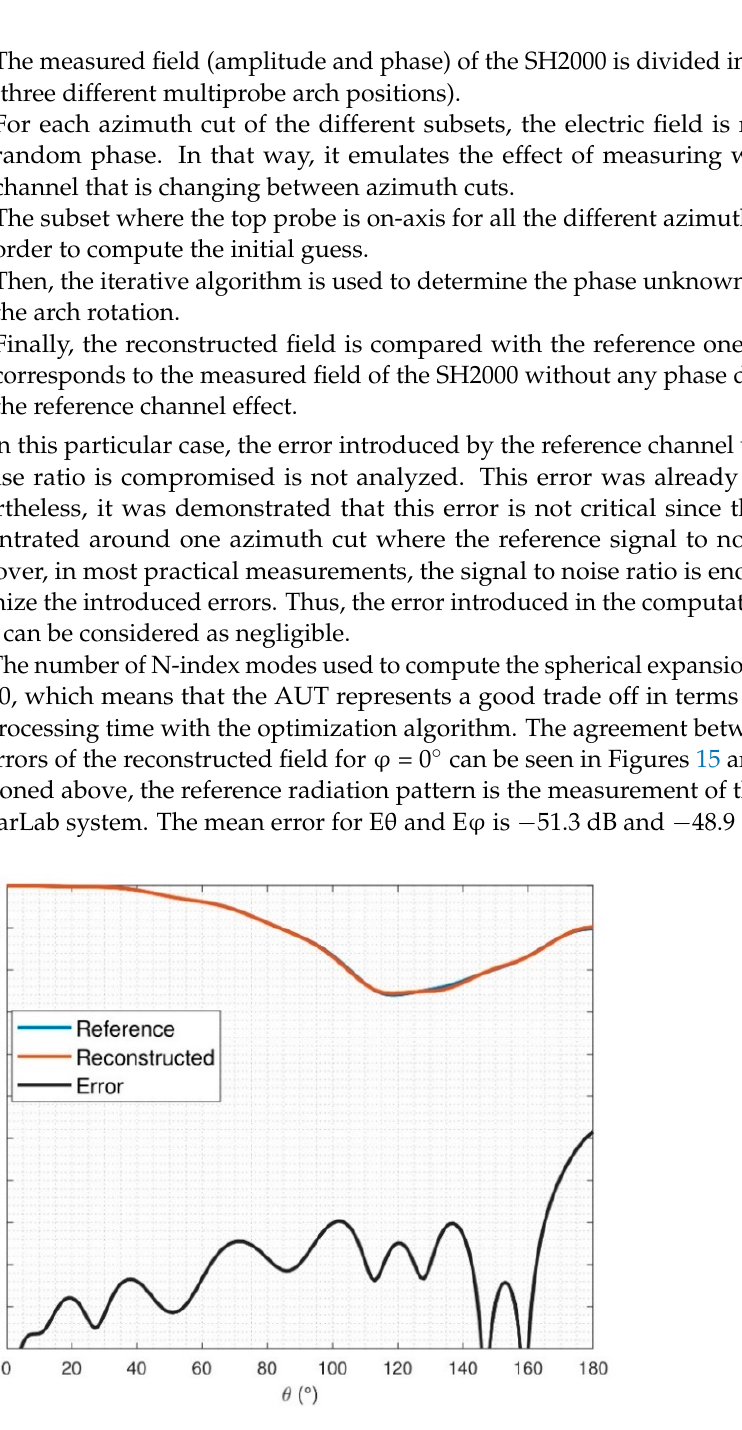
Figure 15. Far ‐ field (FF) comparison after reconstruction of SH2000 for E φ , φ = 0°. Figure 15. Far-field (FF) comparison after reconstruction of SH2000 for E ϕ , ϕ = 0 ◦